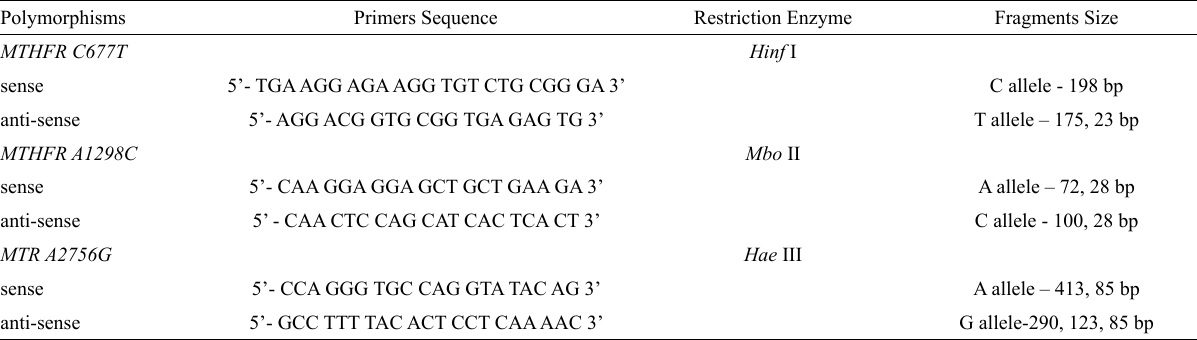
Table 1 ‒ Primers sequence, restriction enzyme and fragments size.